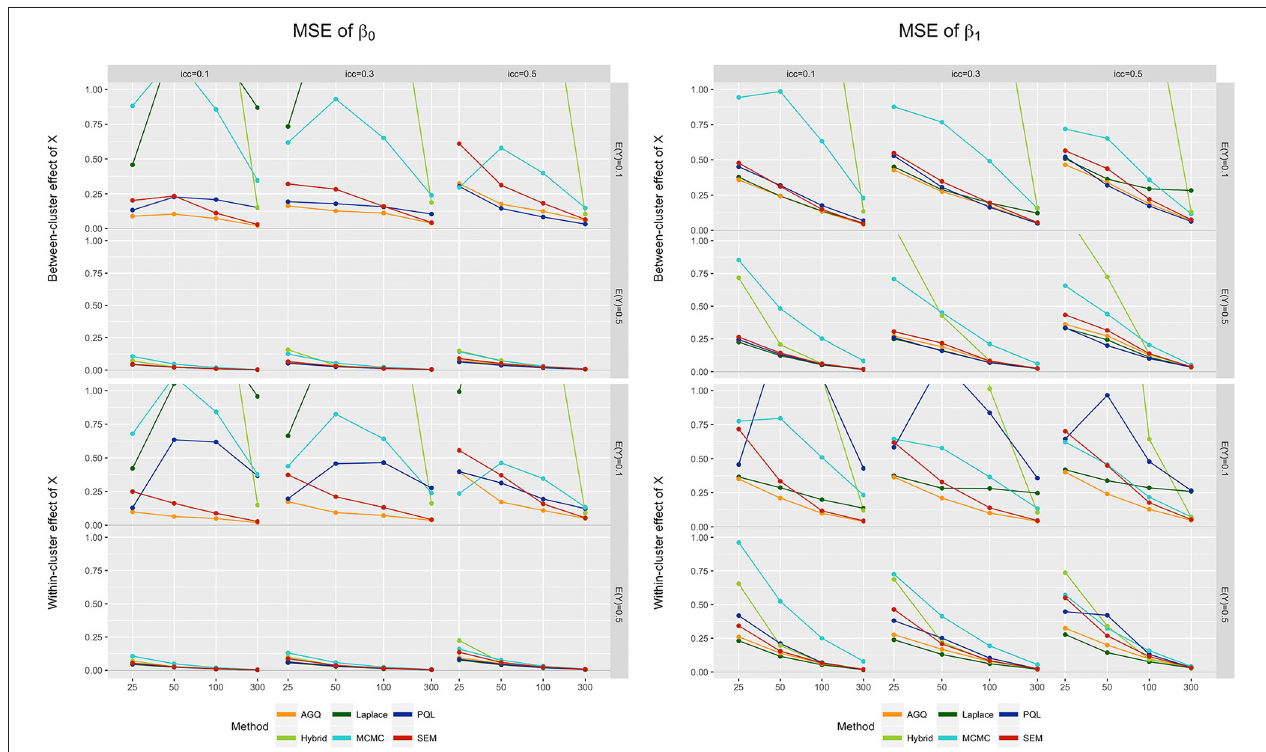
FIGURE 5 | MSE of β 0 (left) and β 1 (right) for the six approaches, for different measurement levels of X (within- or between clusters), outcome prevalences (0.1 and 0.5), different icc l (0.1, 0.3, and 0.5), and sample sizes (25, 50, 100, and 300). These results stem from simulation runs where all methods